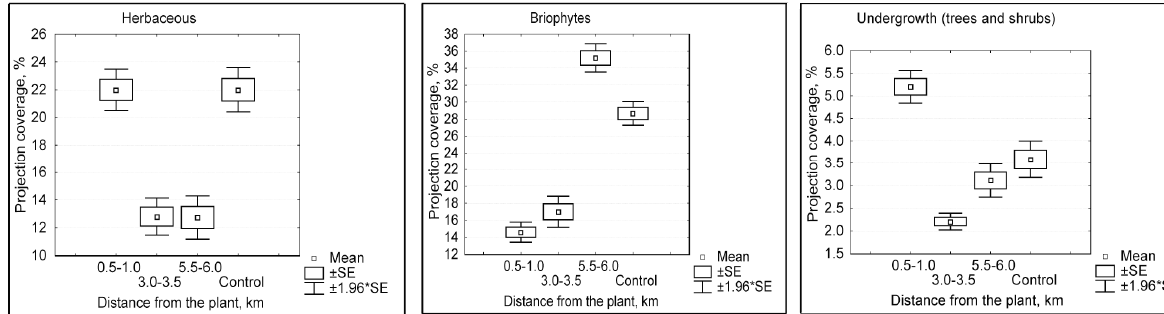
Fig. 6. Mean projection coverage % of vegetation species at different distance from the pollution